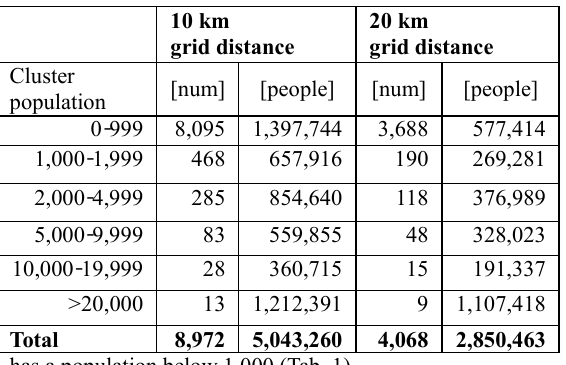
Table 1. Number and population of population clusters in 10 and 20 kilometre distance to the grid; categorized according to the cluster population size.